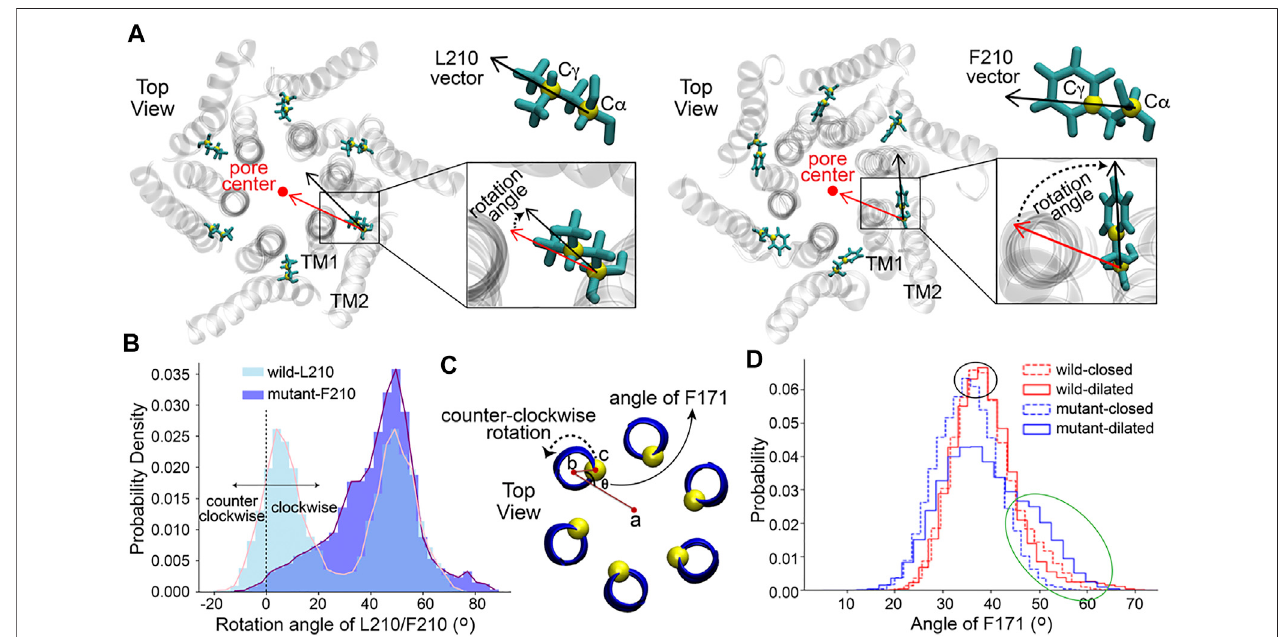
FIGURE 3 | The rotation of residues L/F210 and F171. (A) The de fi nition of the rotation angle of L/F210. The rotation angle was de fi ned by the black and red vectors. The red vector was determined by the projections of C α of residue 210 and the pore center onto the XY plane, and the pore center was the geometry center of C α atoms ofallthesixTM1s. Theblack vectorsofL/F210weredetermined bythe projectionofC α and C c ontotheXYplane. Only theTM1and TM2ineach subunit are shown for clarity. One frame of the simulation is shown with gray transparent NewCartoon as an example. L210 and F210 are shown with Licorice. (B) The distributionoftherotationangleofL/F210.Thelast200 nsofeachtrajectorywasusedforthisanalysis.VMDwasusedforthecalculations. (C) Thede fi nitionoftheangle of F171(top view). Point awasobtained byprojecting the centerofthechannel on the XYplane. Similarly,point b was determined bythe geometry center oftwohelices centeredonF171(residues169 – 173),andpointcwasC α ofF171.Theaxisofrotationpassedthroughpointbandwasparalleltothechannelaxis. (D) Thedistributionof the angle of F171. The four data sets, wild-closed, wild-dilated, mutant-closed and mutant-dilated, were classi fi ed with a pore radius of 2 Å at the K163 gate. 500 ns of each trajectory was used for the analysis. VMD was used for the